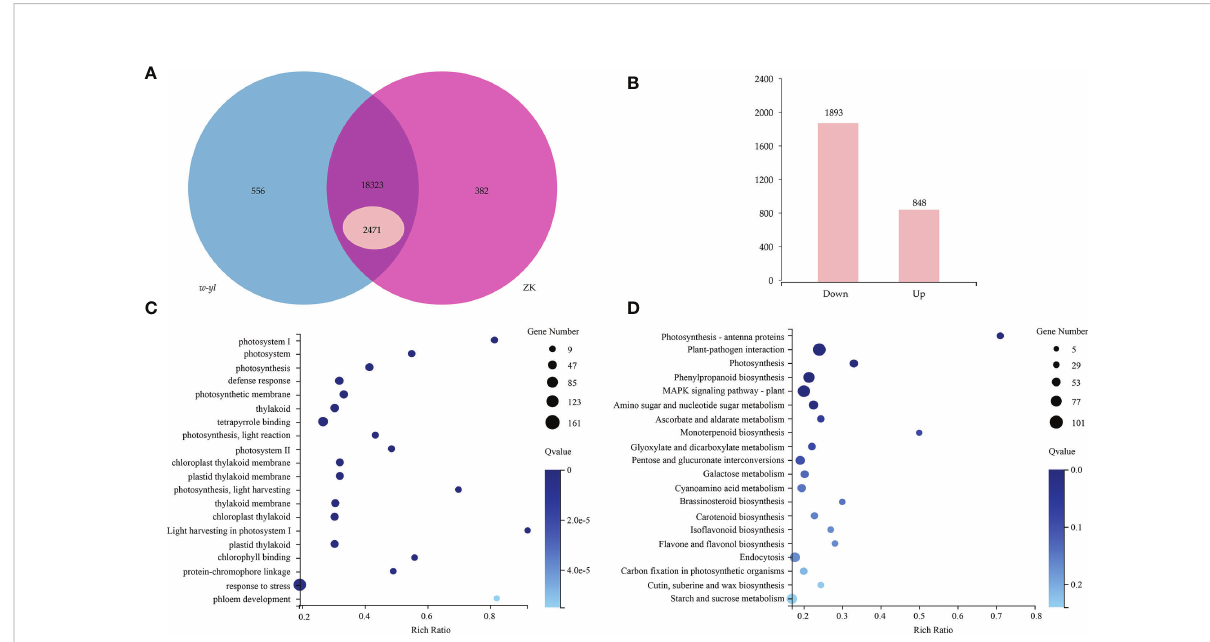
FIGURE 3 RNA-seq analysis for the leaves of w-yl and ZK. (A) Venn diagram of the relationship of w-yl- vs-ZK. (B) Number of up-regulated and down- regulated DEGs. (C) GO enrichment analysis of DEGs. (D) KEGG pathenrichment analysis of